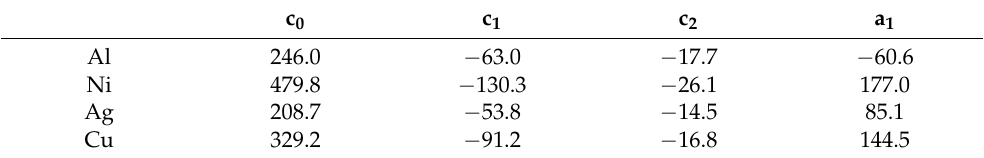
Table 1. The fitted parameters c 0 , c 1 , c 2 and a 1 for the generalized stacking fault energy surface of fcc Al, Ni, Ag and Cu (mJ/m 2 ).